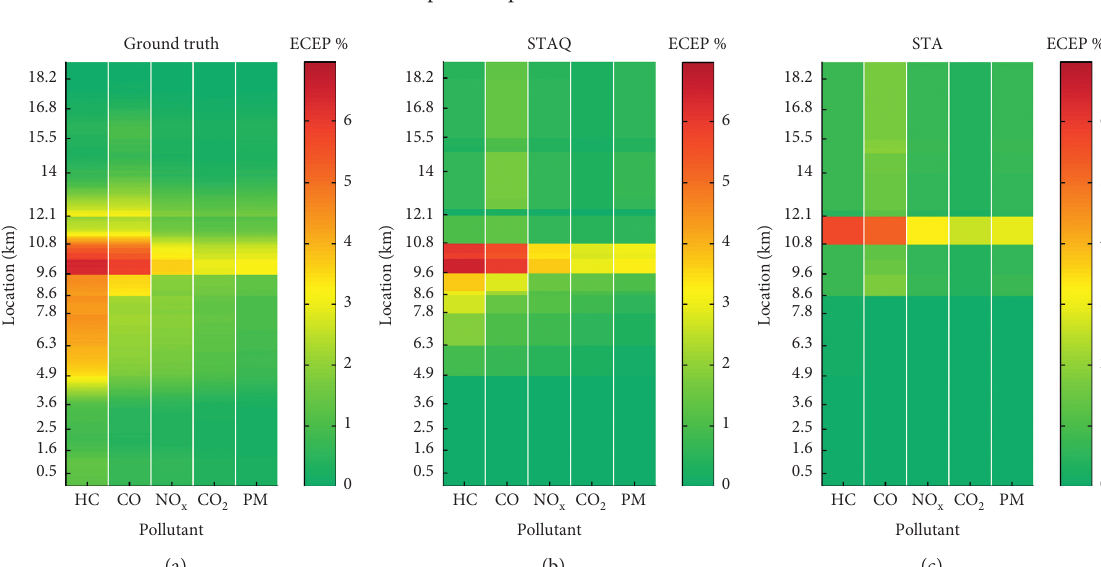
Figure 12: Average excess due to congestion emissions (ECEP) for (a) the ground truth, (b) static loading with queuing, and (c) static